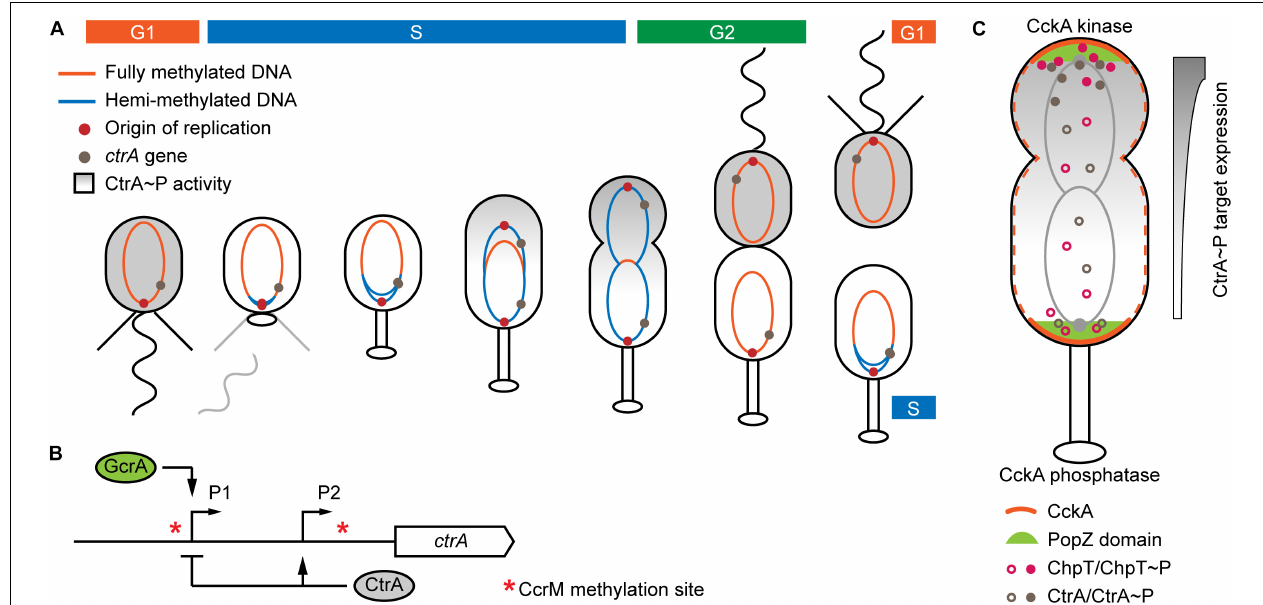
FIGURE 1 | Mechanisms of C. crescentus differentiation for which chromosomal localization matters. (A) Changes of chromosome methylation state and CtrA activity during the C. crescentus cell cycle. Newly replicated DNA stays hemi-methylated during the S phase allowing ctrA transcription to be activated. CtrA activity is restricted to the late S phase and the flagellated daughter cell. (B) Control of ctrA expression. Hemi-methylated P1 is activated by GcrA. Phosphorylated CtrA inhibits expression from P1 and activates expression from P2. (C) Establishment of a CtrA activity gradient through localized phosphorylation/dephosphorylation. The protein environment at the new pole triggers kinase functionality of CckA. The PopZ microdomain ensures proximity of phosphorelay components. Panel A inspired by Panis et al. (2015) and panel C inspired by Lasker et al.